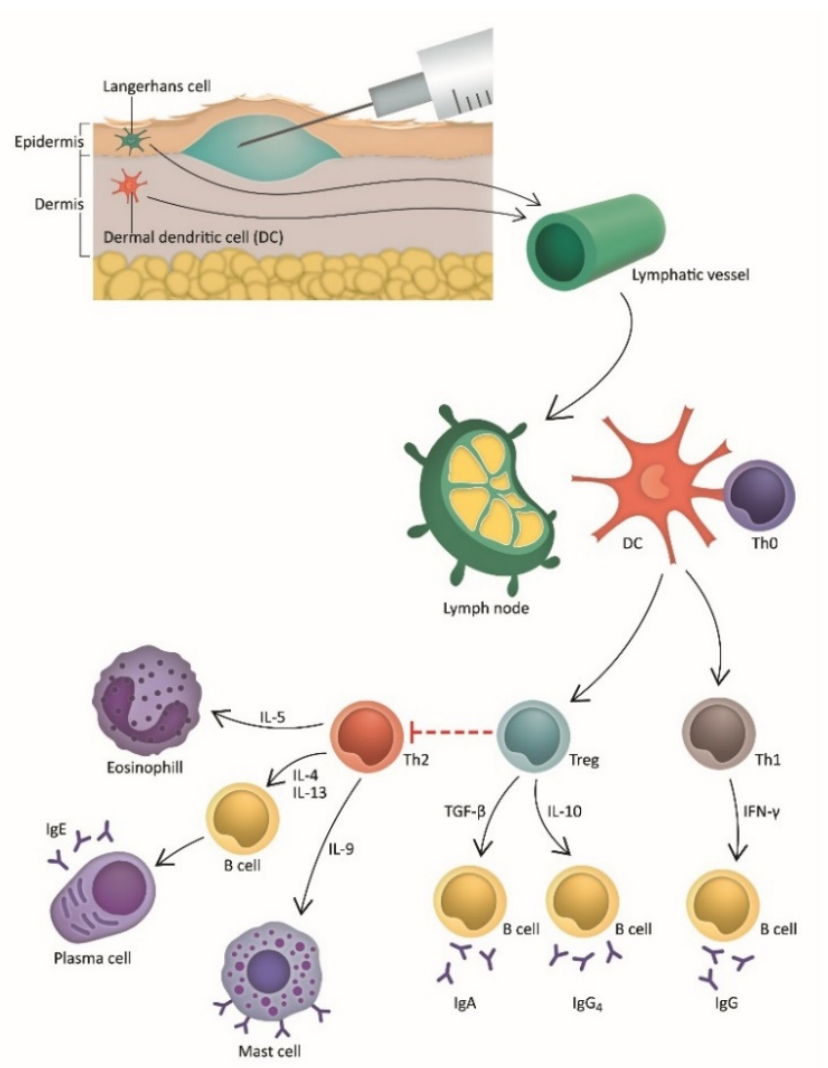
Figure 1. The mechanism of intradermal immunotherapy (IDIT). Abbreviations: DC, dendritic cells; Ig, immunoglobulin; IL, interleukin; Th, T helper cells; Treg, regulatory T cells.